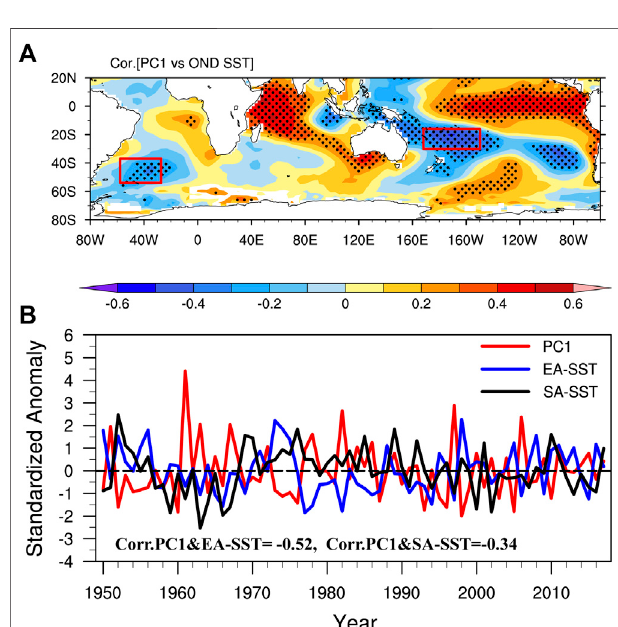
FIGURE 5 | (A) Spatial distribution of correlations between PC1 and Southern Ocean Sea Surface Temperature for OND season during 1950 – 2017. Regions above the 95% Con fi dence level are dotted. (B) Normalized time series of the PC1 of OND rainfall over Tanzania (PC1) and SST anomalies indices averaged over EA-SST (16 ° – 30 ° S, 165E ° – 155 ° W) and SA-SST (37 ° – 54 ° S, 20 ° – 49 ° W) during 1950 – 2017.